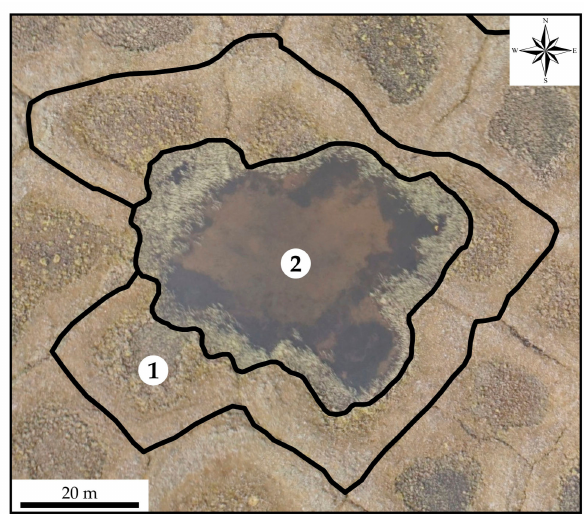
Figure 7. An example of collapsed polygons (CP; number 1 in a white circle) and a mapped pond (2), which is related to lakes and other water bodies. This is an orthophoto map that is mixed with a GSR map.